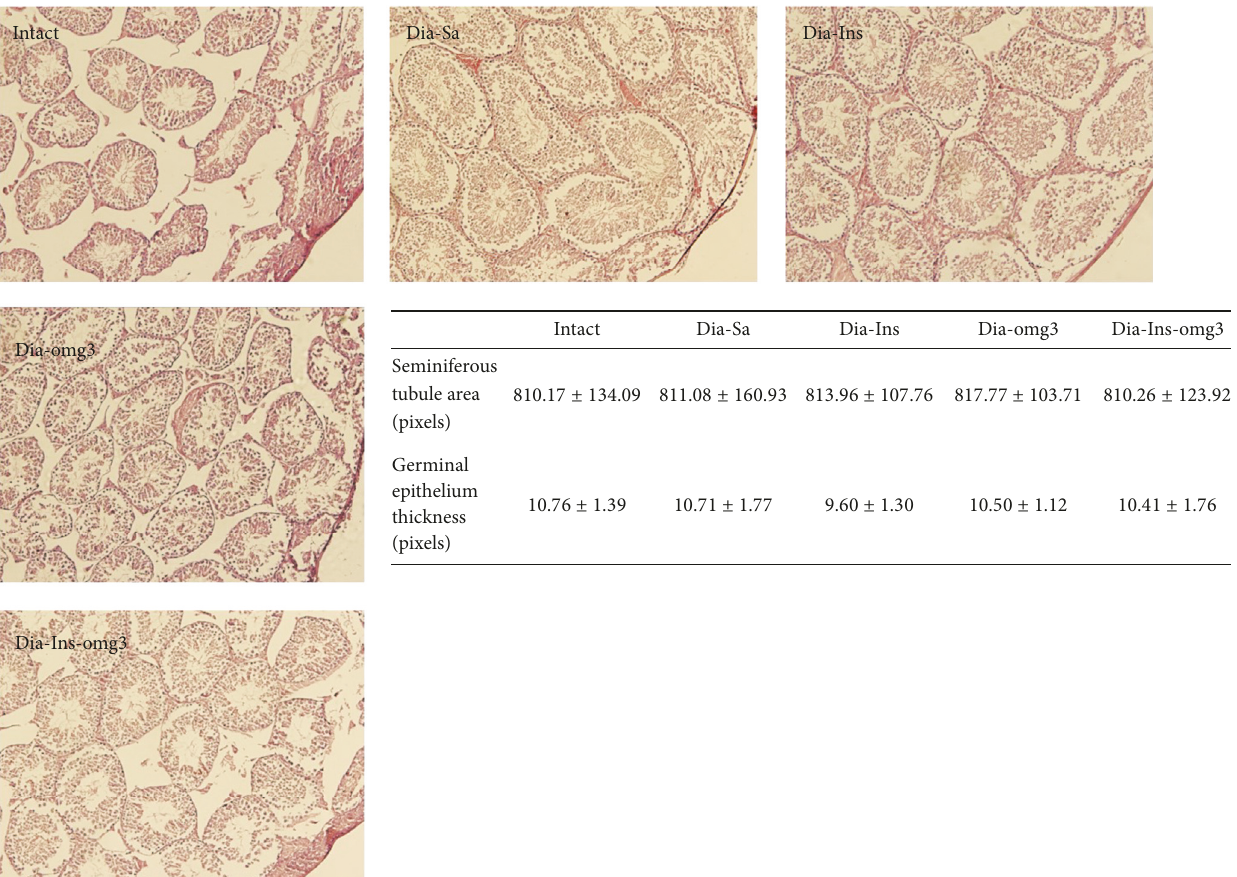
Figure 2: It shows testes structure in the intact, diabetic-saline (Dia-Sa), diabetic-insulin (Dia-Ins), diabetic-omega3 (Dia-omg3), and diabetic-insulin-omega3 (Dia-Ins-omg3) groups. Measurement of seminiferous tubular area and germinal epithelium thickness revealed no statistically significant differences among the